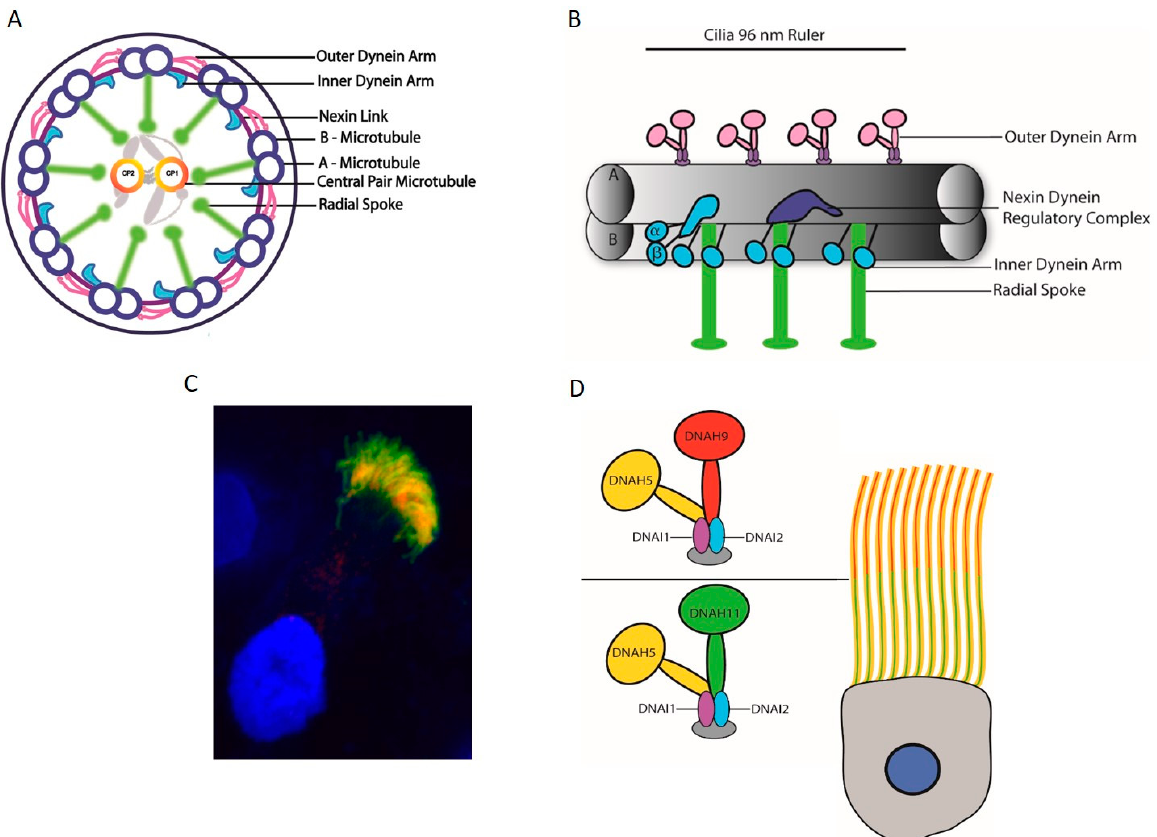
Figure 4. Schematic representation of motile cilia. ( A ) Motile cilia structure showing a 9 + 2 arrangement of microtubules, inner and outer dynein arms attached to the A microtubule, the nexin dynein regulatory complex (N-DRC) that links the A microtubule of one peripheral doublet to the B microtubule of the adjacent doublet, and a central pair with associated projections and radial spokes. ( B ) Four ODAs, one double headed IDA and six single-headed IDAs, accompanied by three radial spokes and one N-DRC protein complex, form a 96 nm ruler distributed along the axoneme of the motile cilia. ( C ) Immunofluorescence of motile respiratory cilia (green: DNAI1, red: acetylated tubulin, and blue: DAPI). ( D ) Outer dynein arm subtypes in human respiratory cilia. Two ODA subtypes defined by the localization of dynein heavy chains can be distinguished: DNAH11 localizes to the proximal half, while DNAH9 is found in the distal half of human respiratory cilia.